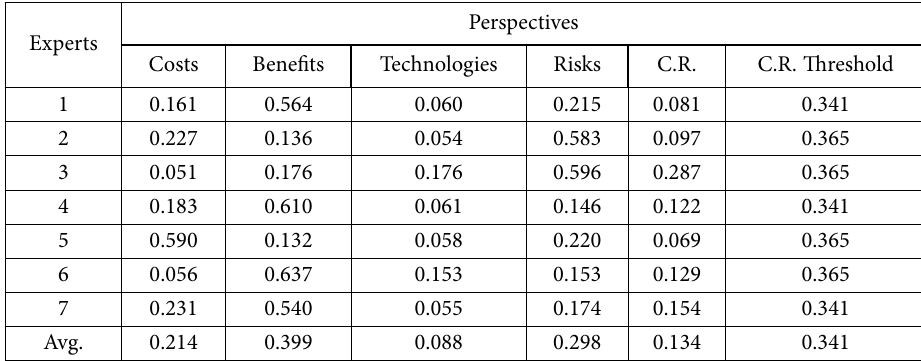
Table 9. The weights and consistency ratio in